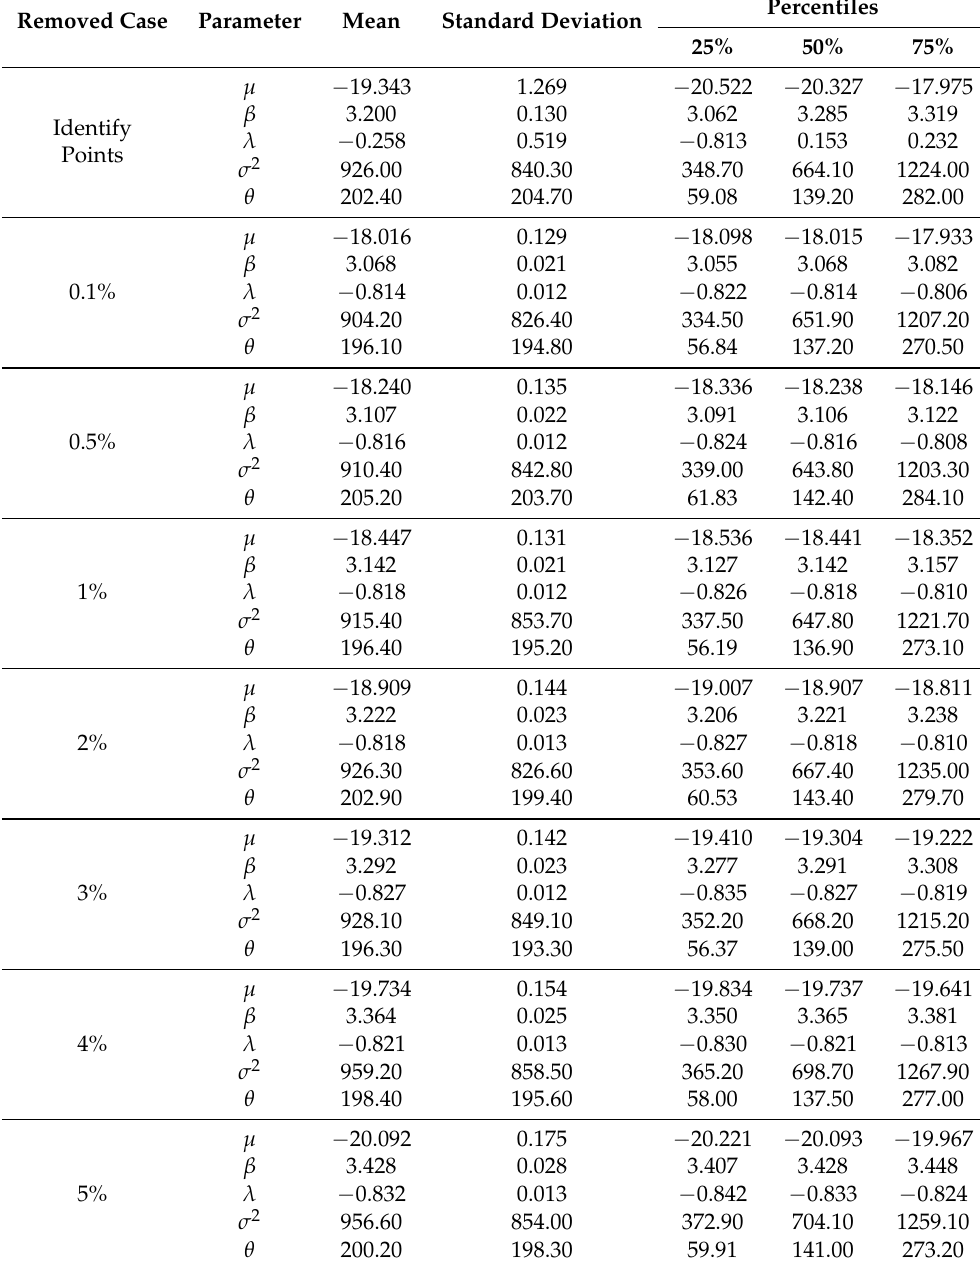
Table 5. Posterior model summary of the hierarchical TLL model